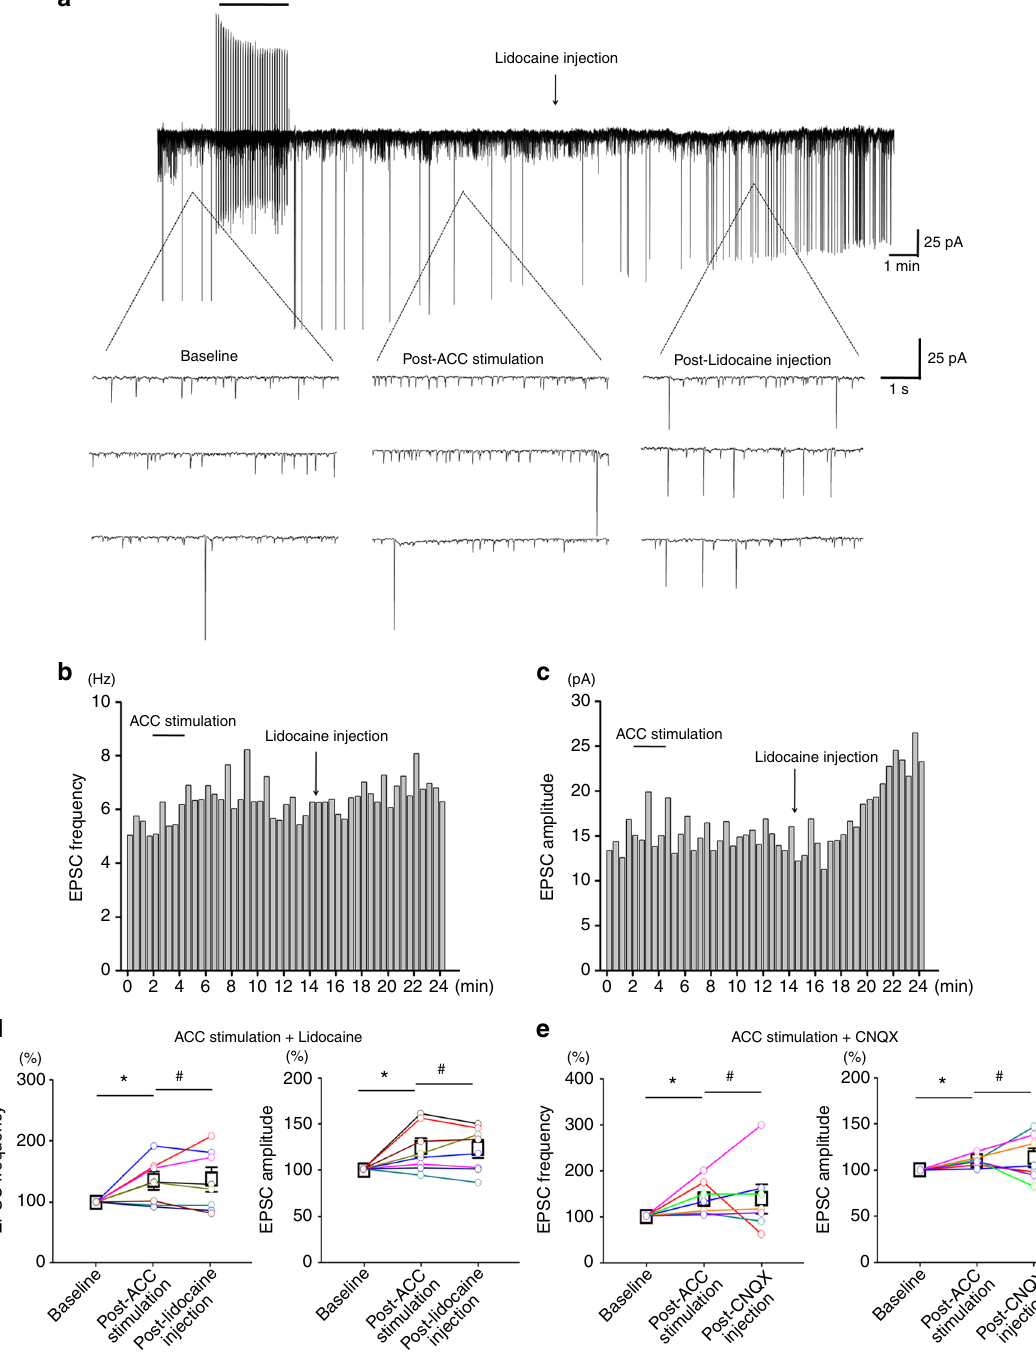
Fig. 4 RVM blockade did not reverse ACC stimulation-induced potentiation of the spinal sEPSC in sham operated rats. a – c One sample ( a ) and the histogram fi gures showing the frequency ( b ) and amplitude ( c ) of the spinal sEPSC were potentiated by ACC stimulation, which could not be reversed by following lidocaine blockade of RVM. d Summarized results from 8 SDH neurons with ACC stimulation and lidocaine injection. *frequency: p = 0.03; amplitude: p = 0.04. One-way RM ANOVA. e Summarized results from 7 SDH neurons with ACC stimulation and CNQX injection. *frequency: p = 0.04; amplitude: p = 0.02. One-way RM ANOVA. # p > ( p < 0.05) (Supplementary Fig. 2e, i and j). ACC stimulation or lidocaine injection could not increase the Fos expression in laminae I – V ( p > 0.05) (Supplementary Fig. 2f, g and j). In rats with RVM lidocaine injection and following ACC stimulation, the Fos expression was not changed ( p > 0.05) (Supplementary Fig. 2h and j).